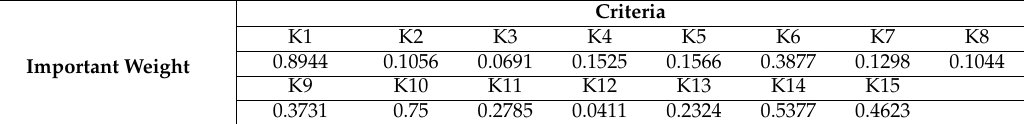
Table 6. The weights of the evaluation criteria using ANP.